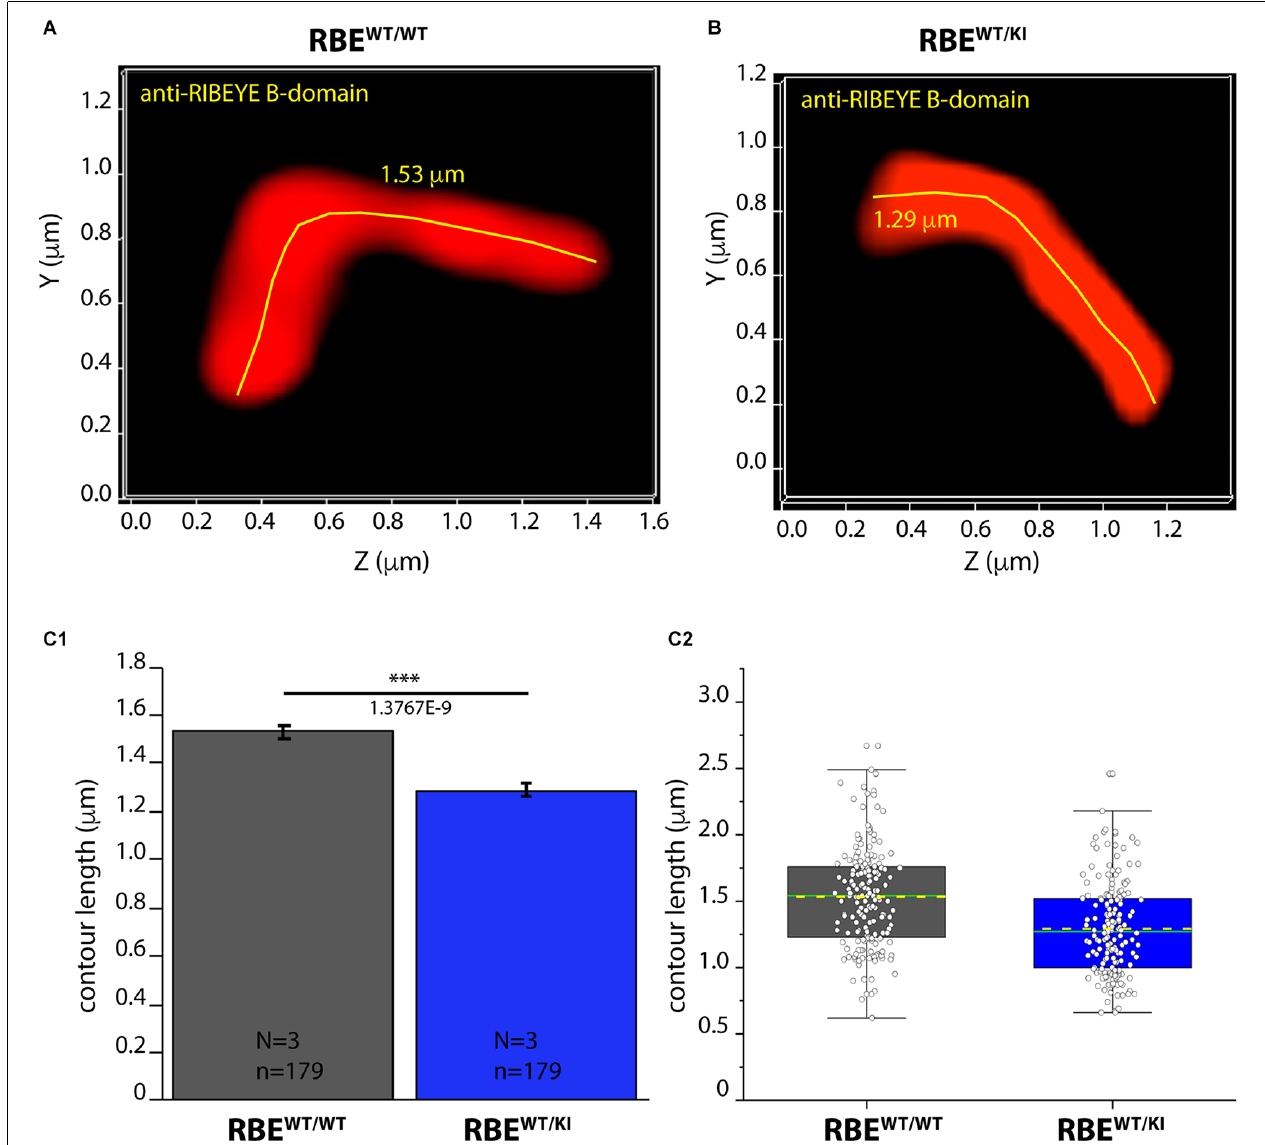
FIGURE 8 | Contour length of synaptic ribbons is reduced in RBE WT/KI mice in comparison to RBE WT/WT mice [3D SR-SIM of ribbons immunolabeled with anti-RIBEYE(B)]. 1.5 µ m-thin retina sections of mice from the indicated genotypes were immunostained with anti-RIBEYE B-domain antibody (2D9) and processed for 3D SR-SIM. (A,B) Representative 3D SR-SIM images of individual synaptic ribbons from rod photoreceptor synapses of RBE WT/WT mice and RBE WT/KI mice. The yellow lines specify examples of the contour length of rod synaptic ribbons. (C1,C2) Quantitative analysis of the contour lengths of rod photoreceptor synaptic ribbons were measured as maximum 2D projections from the 3D SR-SIM images, as previously described (Dembla et al., 2020; Mukherjee et al., 2020; Kesharwani et al., 2021). Values in (C1) are means ± S.E.M. (1.5336 ± 0.0281 µ m in RBE WT/WT ; 1.2908 ± 0.0258 µ m in RBE WT/KI ). In the box and whisker plot (C2) of the data from (C1) , mean values are indicated by dotted horizontal lines; median values by solid horizontal lines. Boxes represent the 25th-75th percentiles of data points and whiskers are equal to 1.5 times of the interquartile range (IQR). Mann-Whitney U -test was used to determine the statistical significance. Abbreviations: RBE, RIBEYE; S.E.M., standard error of the mean; N = number of mice; n = number of analyzed images; ∗∗∗ p ≤